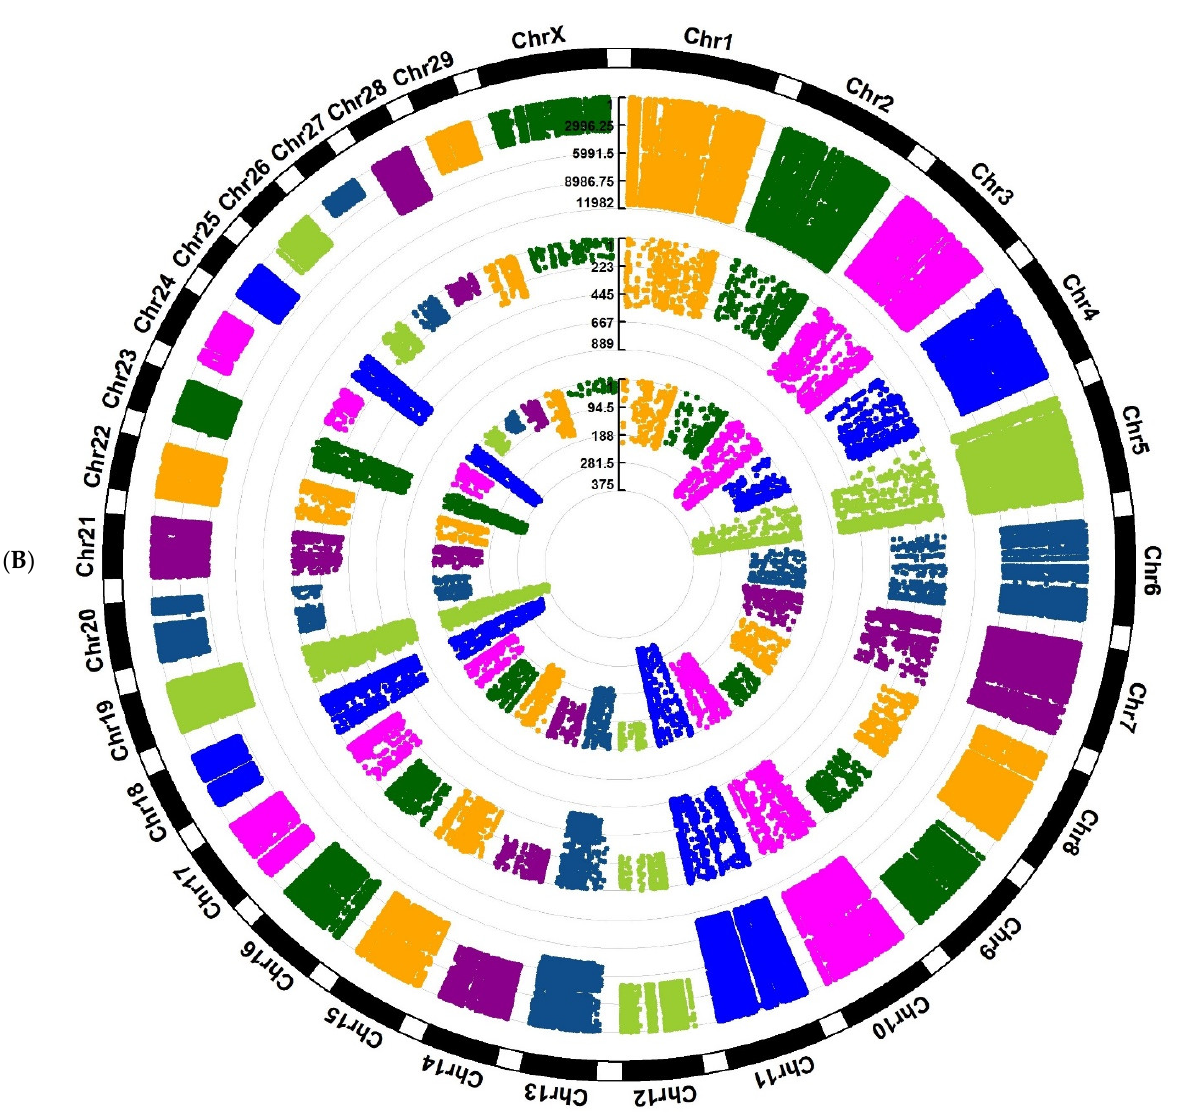
Figure 3. Circos plot of distribution and densities of cow breed and stage-specific SNPs in ( A ) Jersy cow breed and ( B ) Kashmiri cow breed. The external layer displays the chromosomes. The BP, P, and AP-specific SNPs are situated in the first, second, and third inner layers, respectively. Vertical lines in each layer represent the number of SNPs in that position.